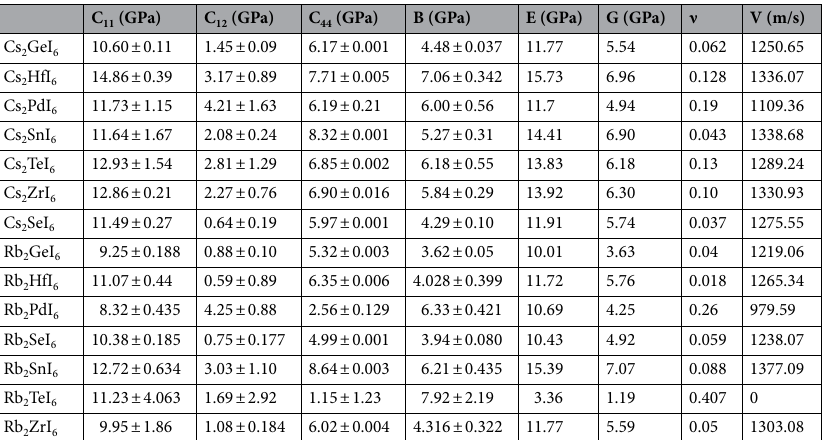
Table 2. Elastic Modulus of Iodide Inorganic Perovskites.